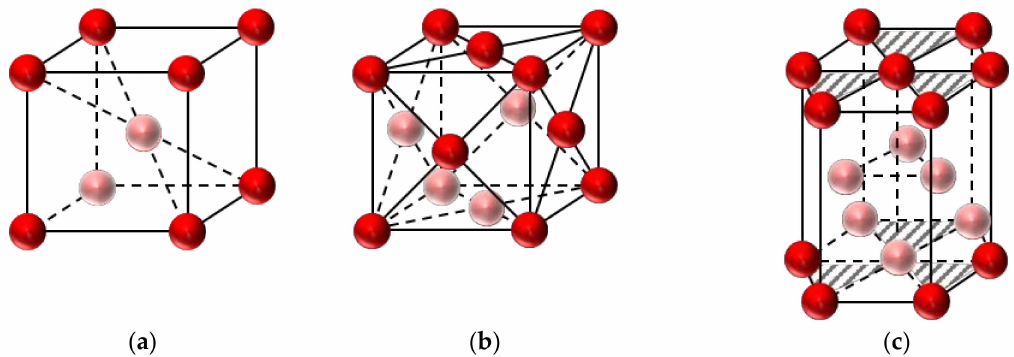
Figure 2. Crystal lattices (adapted from [34]): ( a ) α -Martensite (bcc); ( b ) γ -Austenite (fcc); ( c ) ε - Martensite